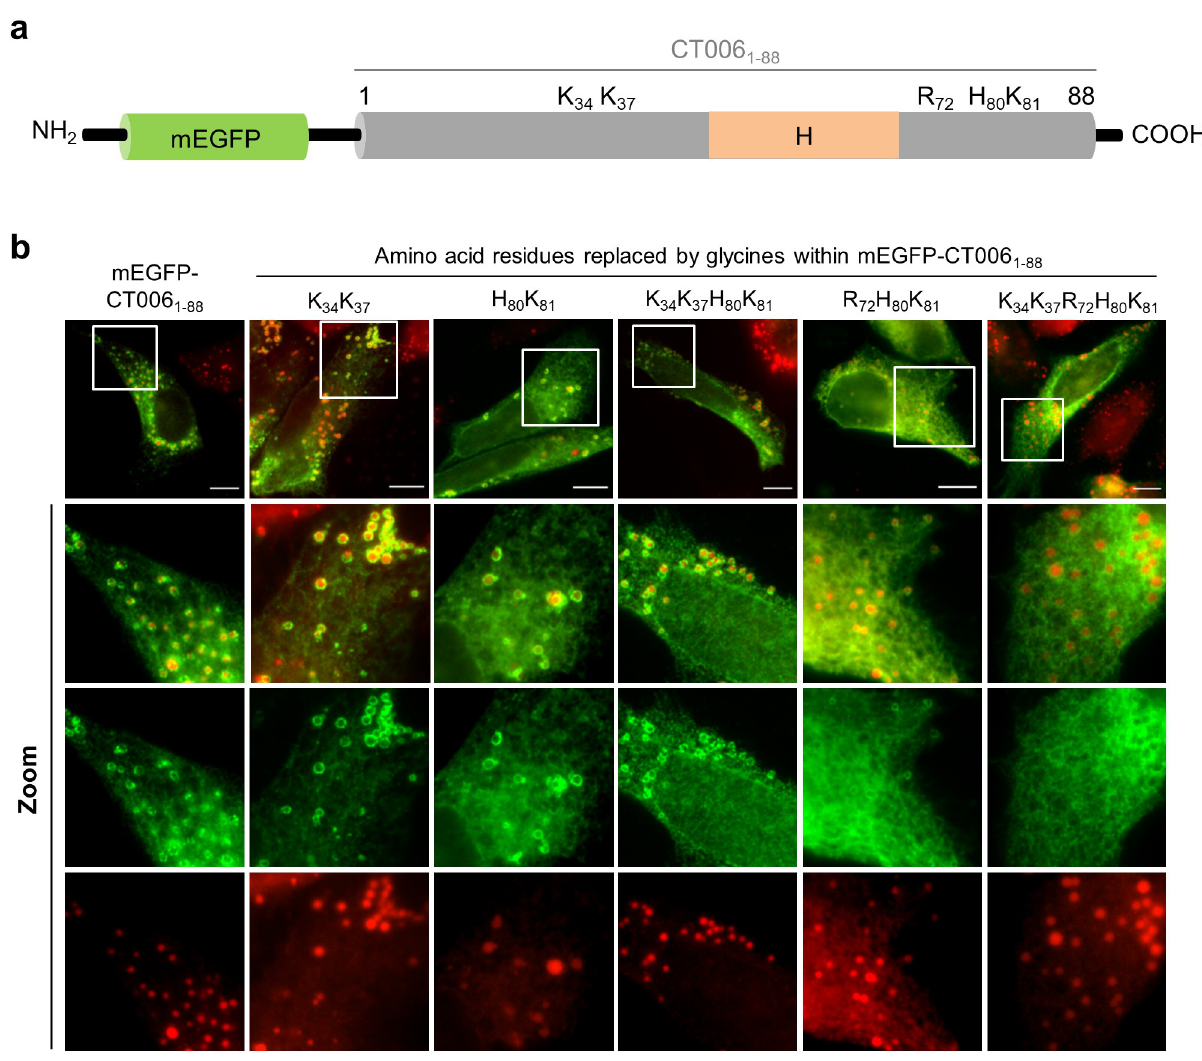
Fig 4. Positively charged amino acids within CT006 1-88 are important to target mEGFP-CT006 1-88 to LDs in mammalian cells. (a) Schematic representation of the position of positively charged amino acids within CT006 1-88 (not drawn to scale); H, Putative hydrophobic domain. (b) HeLa 229 cells were transfected with plasmids encoding mEGFP or different mEGFP-CT006 1-88 versions where the indicated amino acid residues were replaced by glycines (G). At 18 h post-transfection, cells were treated with 100 μ M oleic acid for 6 h and fixed with 4% (w/v) PFA. Fixed cells were labeled with anti-GFP and the appropriate fluorophore-conjugated secondary antibody, stained with Oil Red O (3:2 v/v Oil Red O stock solution diluted in water), and imaged by fluorescence microscopy. Scale bars, 10 μ m. In the areas delimited by white squares images were zoomed.